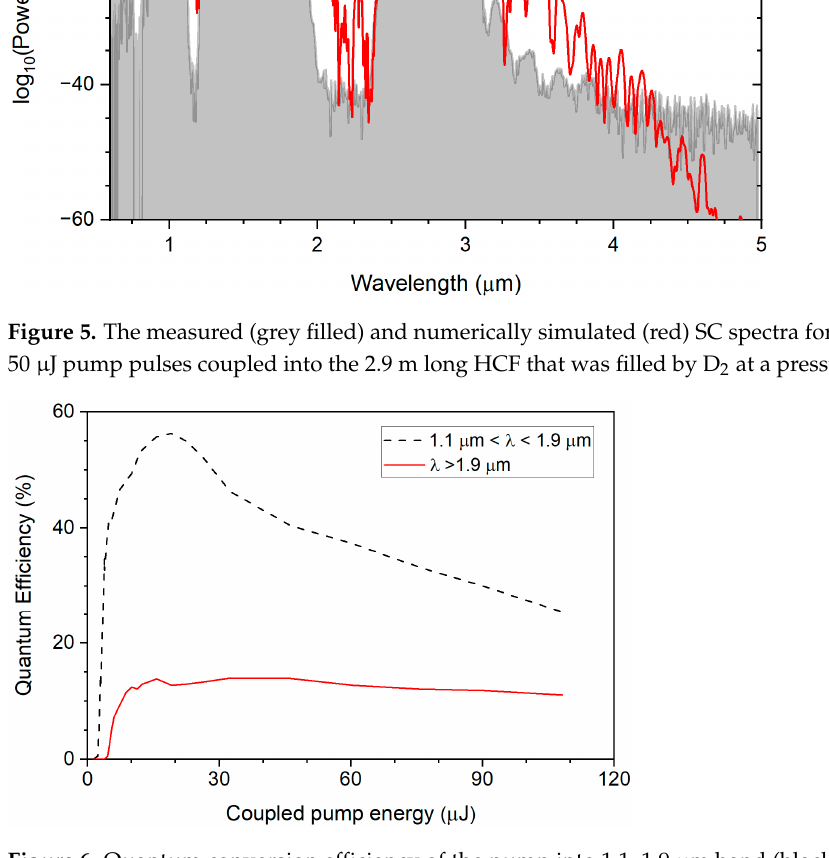
Figure 7. The spectra measured at the output of the HCF for pump pulse duration of 12 ps (blue curve) and 1 ps (red curve). The coupled pump pulse energy was 50 μ J, the pressure of D 2 was 30 atm, and thefiber length was 2.9 m. The optical loss spectrum of the HCF is also shown (grey filled curve). Results of numerical simulations agreed well with the experiment, as can be seen in Figure 5, where measured (grey filled) and calculated (red) output spectra are compared for the case of 1 ps pulses with an energy of 50 μ J coupled into the 2.9 m long HCF that was